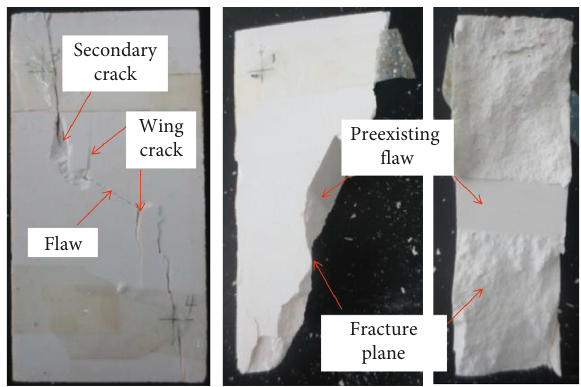
Figure 11: Internal rupture of sample.